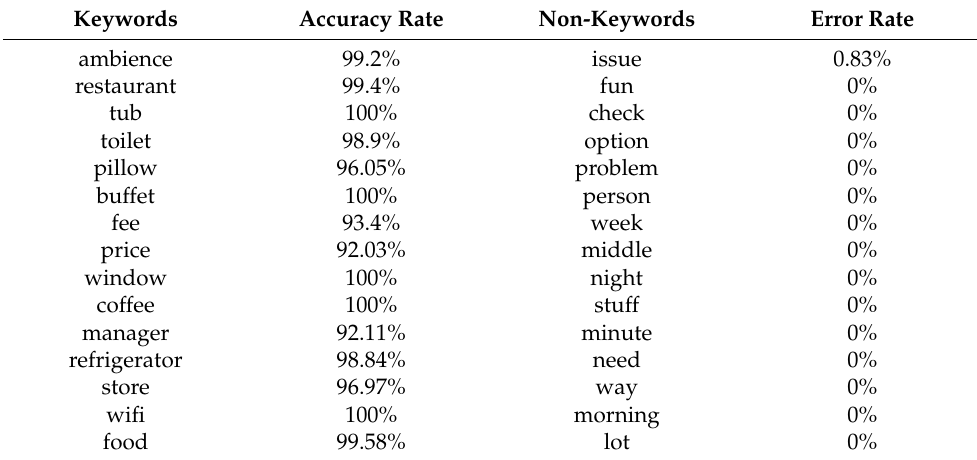
Table 4. Selective keyword detection accuracy for the testing set.